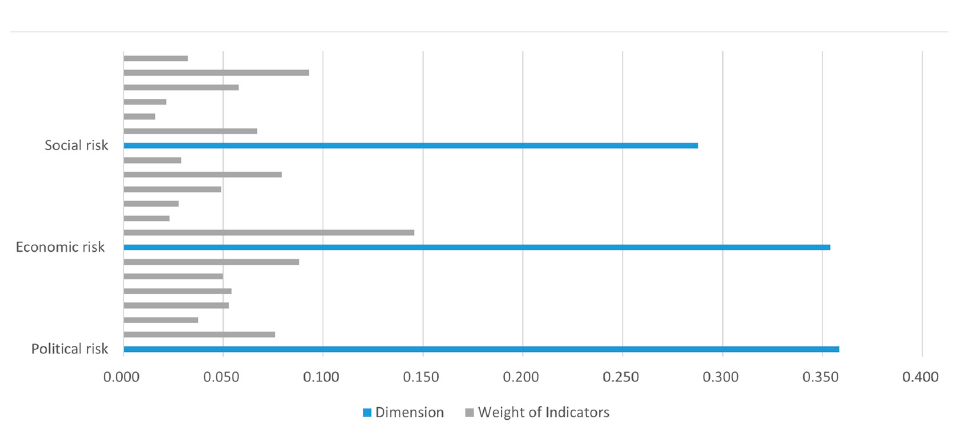
Figure 2. Determined criteria weight (3-D).